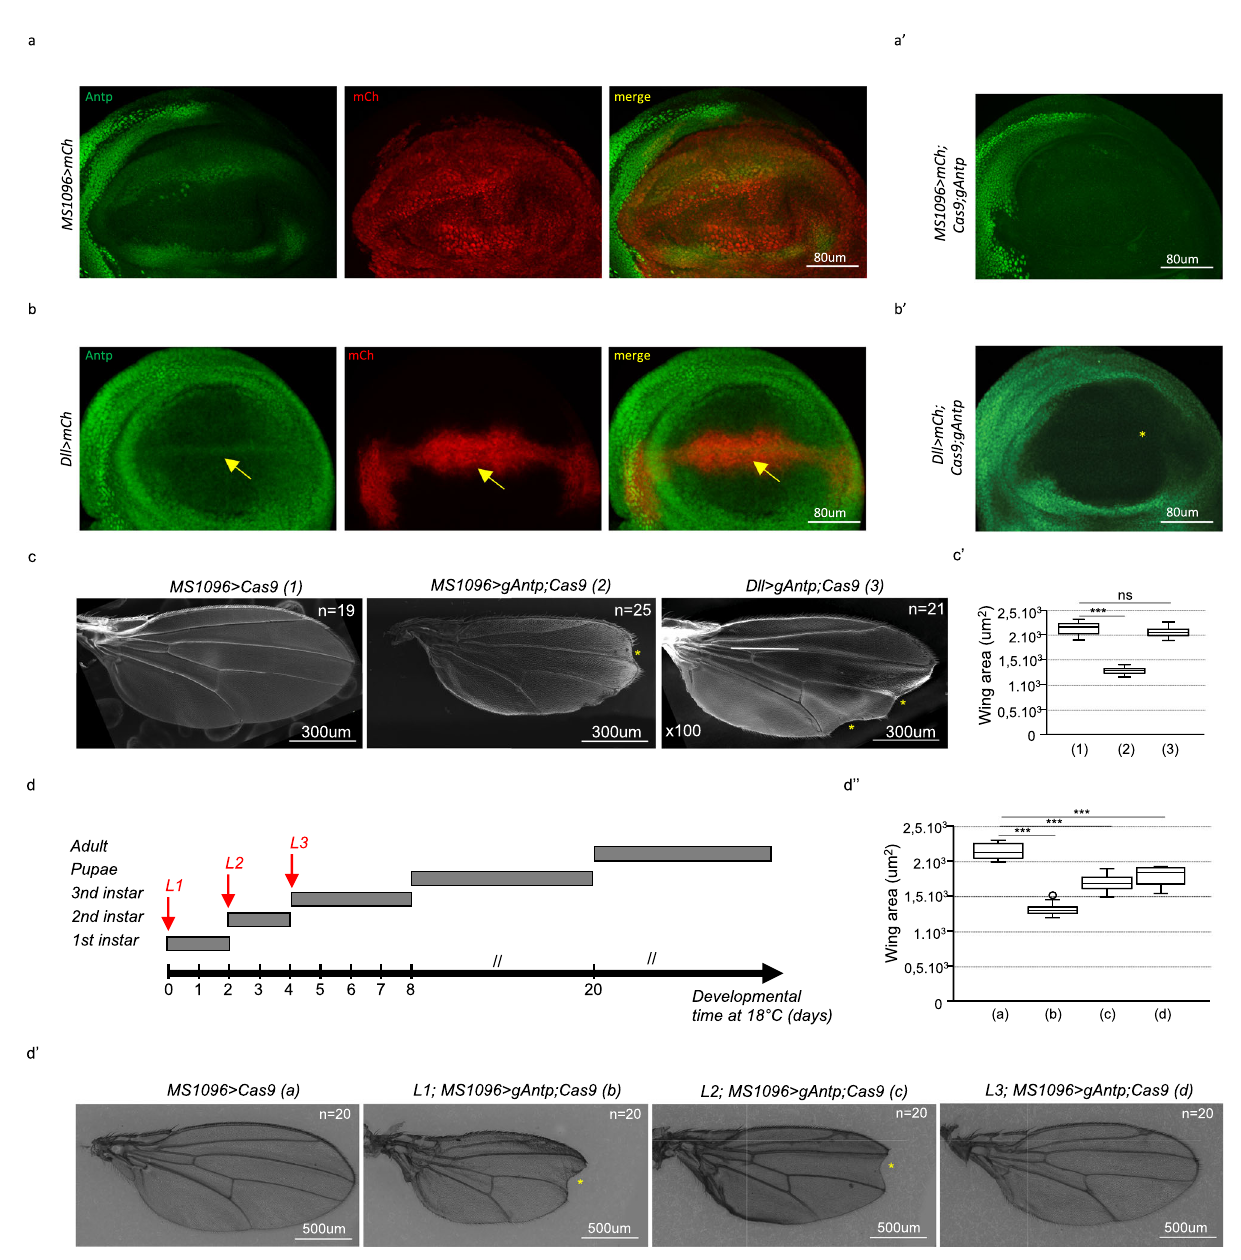
Fig. 2 Antennapedia ( Antp ) is required for correct distal wing formation in Drosophila . a , b Expression of the red fl uorescent reporter mCherry (mCh, red) with the MS1096-Gal4 ( a ) or Distalless(Dll)-Gal4 ( b ) driver does not affect the expression of Antp (green) in the wing pouch ( n = 5 from one experiment). Yellow arrow highlights Dll-Gal4 and Antp co-expressing cells along the dorsal – ventral boundary of the early L3 wing disc pouch. a ′ , b ′ Expression of gRNAs and Crispr/Cas9 against Antp with MS1096 ( a ′ ) or Dll-Gal4 ( b ′ ) abolished the expression of Antp (green; n = 10 from two independent experiments). Note that MS1096 starts at the L1 stage and its expression pro fi le is not restricted to the pouch. c Illustrative SEM pictures of adult wings from control ( MS1096-Gal4 driver with UAS-Cas9 , n = 18) and Antp -mutant ( MS1096-Gal4 or Dll-Gal4 driver with UAS-Cas9 and UAS-gRNAs against Antp , n = 25 or 19, respectively) males, as indicated. The yellow star indicates wing margin defect (observed in 61 and 90% of MS1096-Gal4 and Dll-Gal4 dissected wings, respectively). c ′ Boxplot representation of wing area quanti fi cation in the control (1) and MS1096-Gal4 (2) or Dll-Gal4 (3) induced Antp -mutant fl ies. Boxplots indicate 25th and 75th percentiles, whiskers show ±1.5 × IQR and center line depicts median of three biological replicates (unpaired two-tailed t test with Welch ’ s correction *** p = 1.66e − 20 with MS1096 and nonsigni fi cant (ns) with Dll-Gal4 . d Developmental time course of Drosophila larval stages at 18 °C. Shifts at 29 °C to abolish the activity of Gal80 and induce the expression of Antp gRNAs were performed at early L1, L2, and L3 stages, as indicated. d ′ Illustrative pictures of adult wings in the control experiment ( a ) or upon the expression of Antp gRNAs with the MS1096-Gal4 driver at the L1 ( b ), L2 ( c ), and L3 ( d ) stages. Margin defects (yellow stars) were observed when Antp expression was affected at the L1 (58%) and L2 (43%) but not L3 stage. d ″ Quanti fi cation of wing size defects in the different conditions. Boxplots indicate 25th and 75th percentiles, whiskers show ±1.5 × IQR and center line depicts median of three biological replicates (unpaired two-tailed t test with Welch ’ s correction *** p = 1.8e − 24 at L1, *** p = 6.5e − 15 at L2, *** p = 1.2e − 10 at